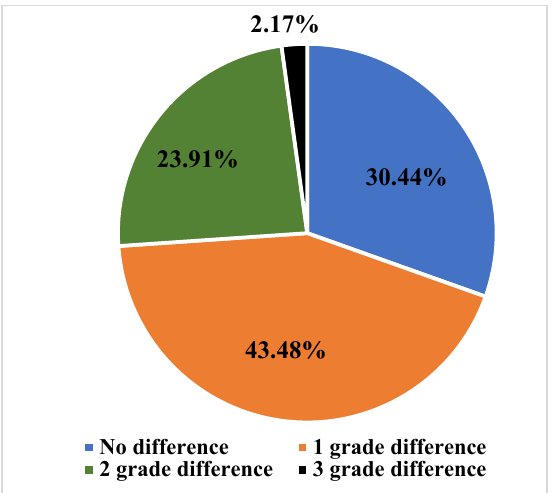
Figure 3. Differences in evaluation grades between experts and management staff.